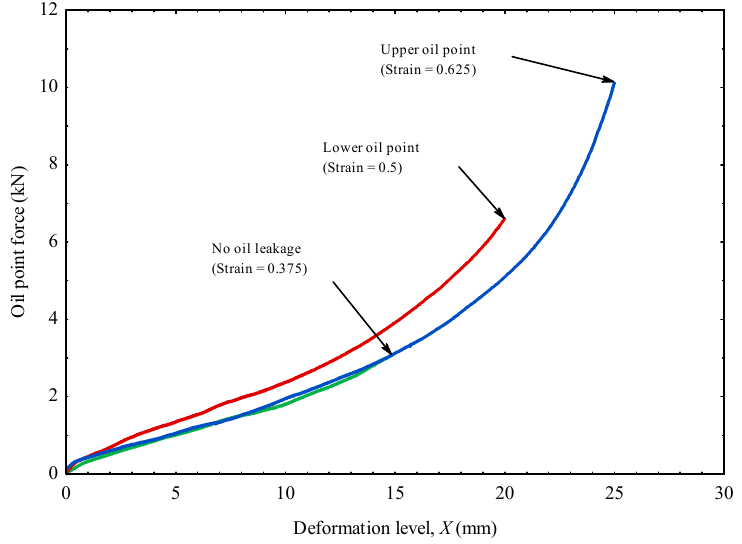
Figure 4. Oil point identification at deformation levels of bulk hazelnut kernels.